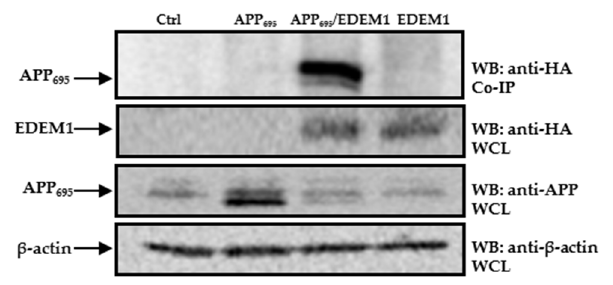
Figure 9. APP 695 interacts with EDEM1. Co-immunoprecipitation of APP from lysates of cells trans- fected with control vector, EDEM1, APP 695, or cells cotransfected with APP 695 and EDEM1. The beads were coated with anti-HA antibodies because the EDEM1-HA construct was used for transfection. Representative example is shown. Whole cell lysates (WCL) were analyzed with anti-HA, anti-APP, or anti β -actin